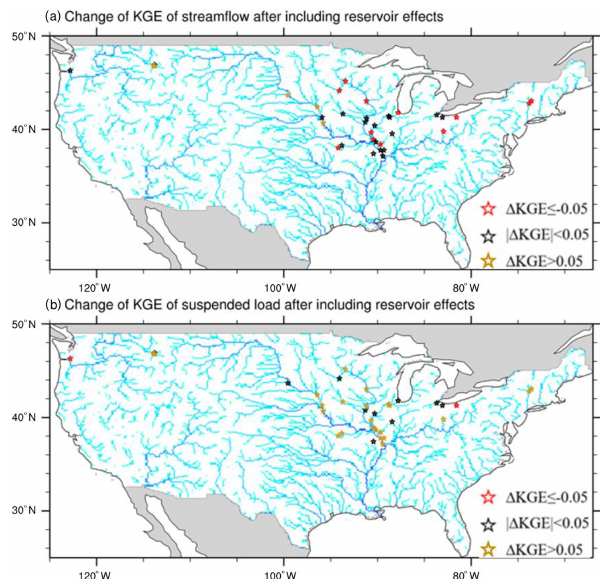
Figure 9. Change in KGE from sim_nat to sim_wm_trapping for monthly streamflow and suspended sediment at the selected USGS stations in 1990–2012. The river network is displayed as a back- ground in terms of the accumulated upstream drainage areas at each grid (in different tones of